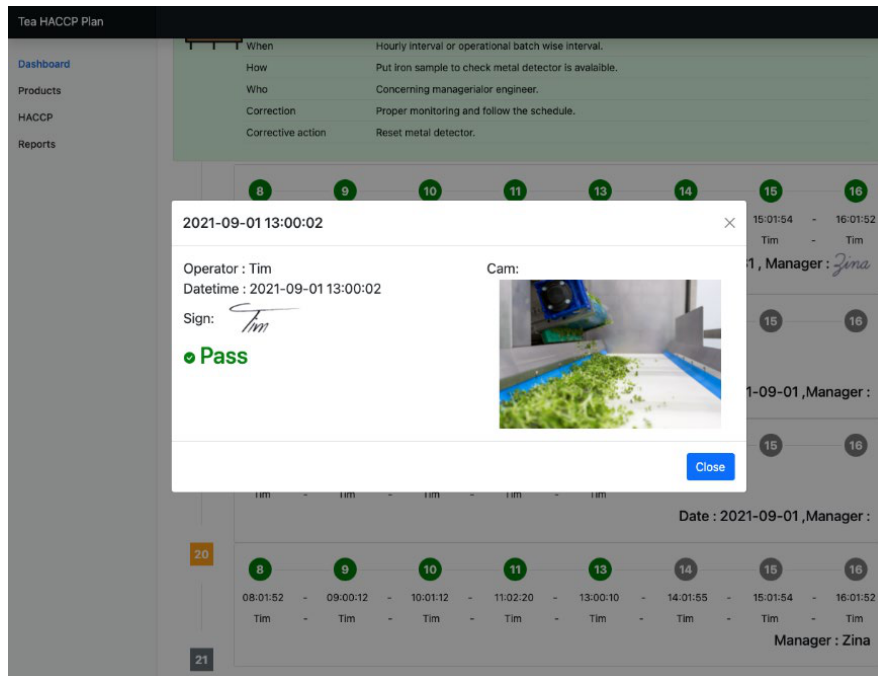
Figure 18. The system implementation of audit detail for CCP reports.